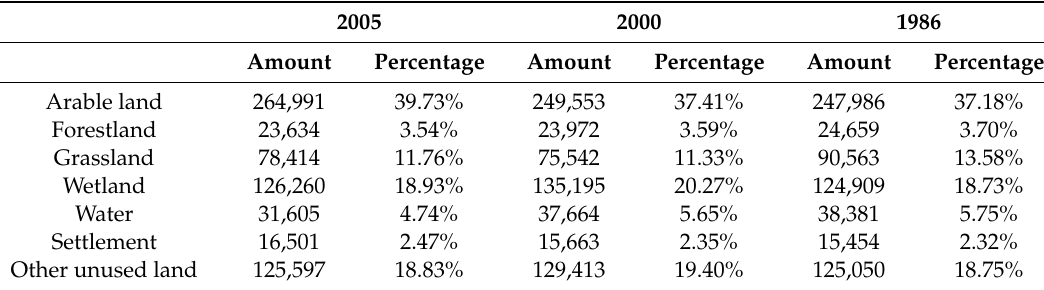
Table 1. Detailed manner of the land use categories in Zhenlai (1986–2005).